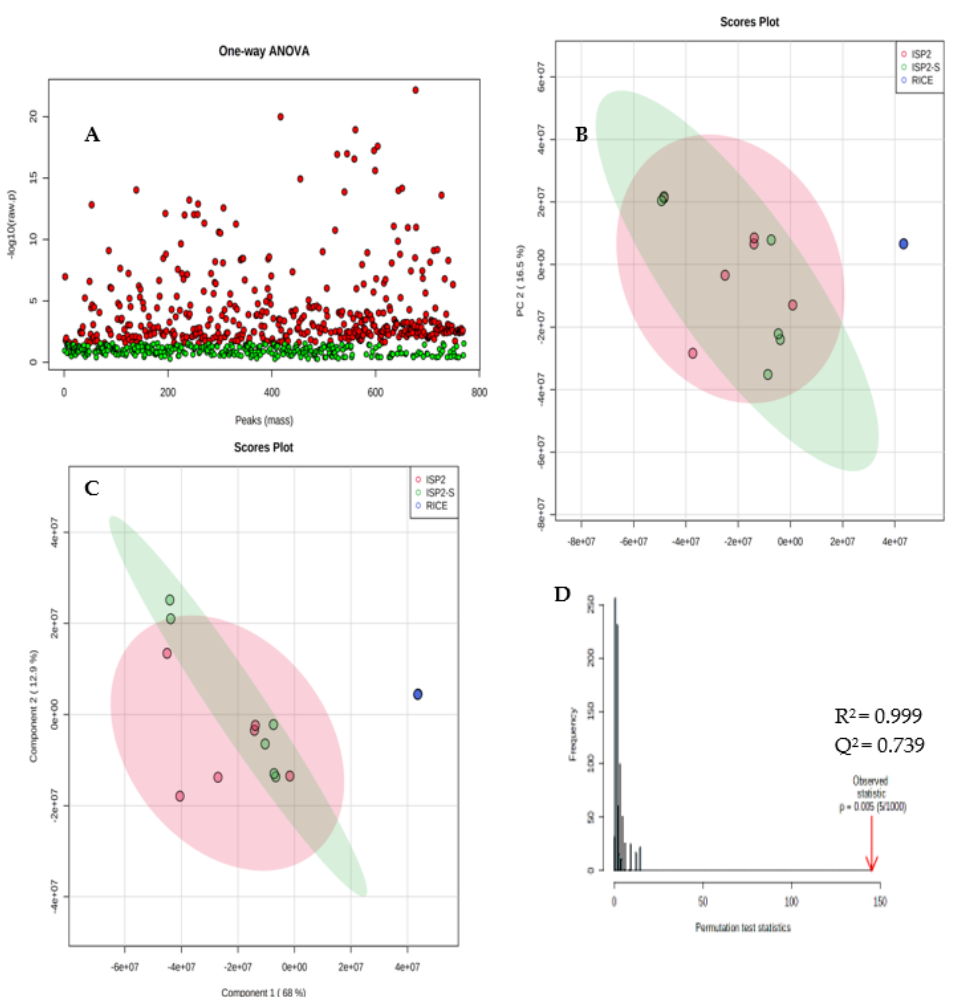
Figure 2. ( A ) Multivariate analysis. ANOVA results show statistically significant metabolites in red. ( B ) Principal Component Analysis (PCA) score plot. Green circles correspond to ISP2 − S extract; pink circles correspond to ISP2 extract; blue circles correspond to RICE extract. ( C ) Partial least squares discriminant analysis PLS − DA model. Colour coding as before. ( D ) A permutation test plot.